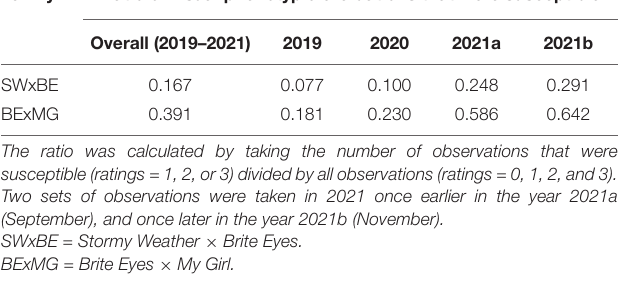
Family Ratio of visual phenotypic evaluations that were